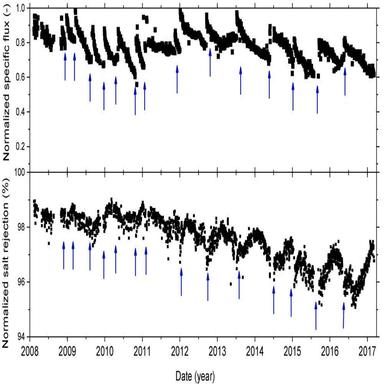
Normalized specific flux (top) and overall salt rejection (bottom) of the RO unit from which membranes were extracted for autopsy. Blue vertical arrows represent periods where membranes were taken off-line for chemical cleaning. Note that although the x-axis spans ~9 calendar years, the membranes had an operational runtime of ~8 years. Specific flux values were calculated after correcting and normalizing flow rates for temperature and conductivity fluctuations. (For interpretation of the references to color